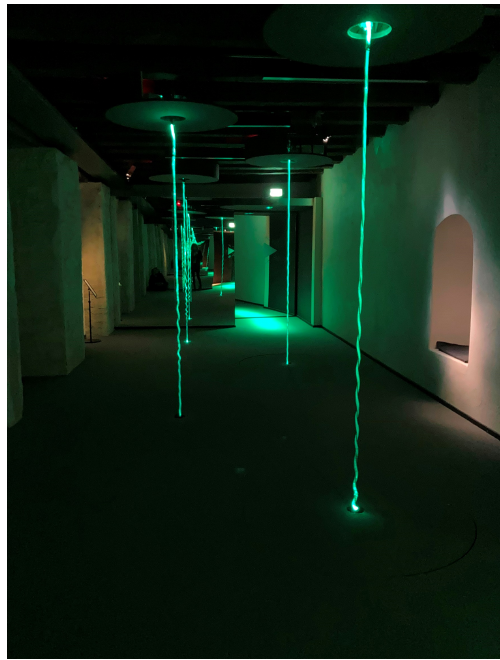
Figure 9. The sound installation in idle mode. The physical interface is the same as in Figure 1a, but the data analysis, sound synthesis, lighting design (i.e., mapping to colors) and haptic feedback are different in this new